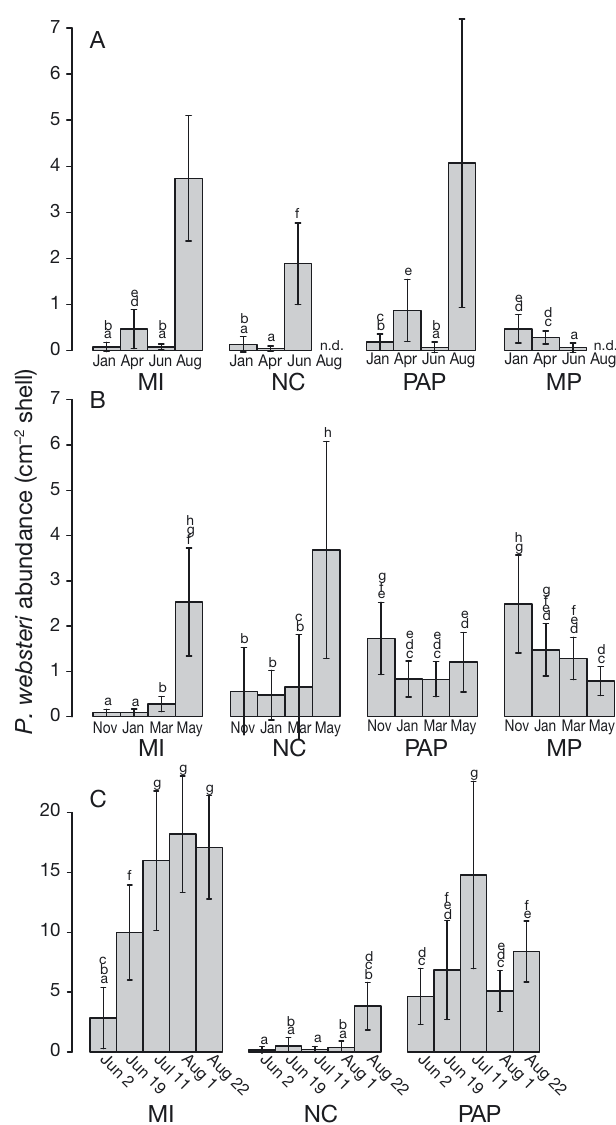
Fig. 3. Mean (±SD) Polydora websteri abundance for the col- lection date × oyster farm location interaction during the (A) 2016 deployment (n = 4), (B) 2017 deployment (n = 4), and (C) short-term summer 2017 deployment (n = 12). Oyster farms abbreviated as follows: Massacre Island (MI); Murder Point (MP); Navy Cove (NC); Point aux Pins (PAP). Letters